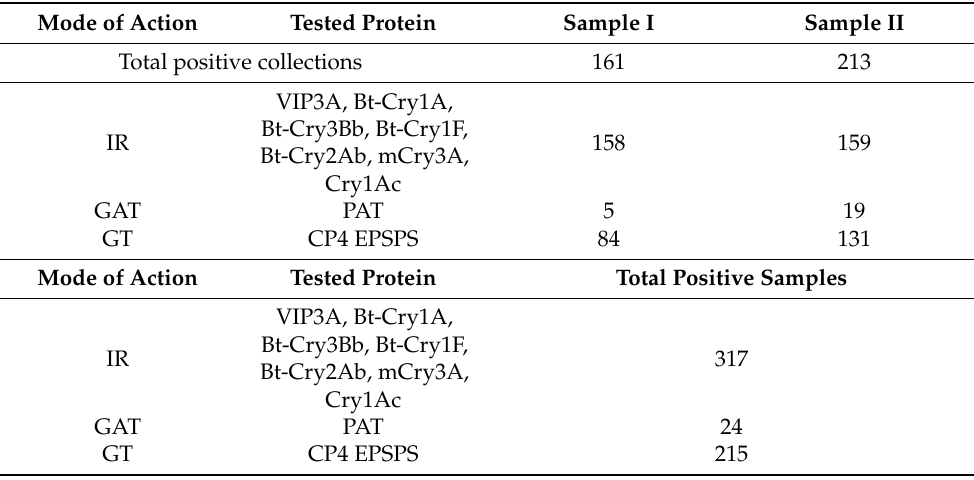
Table 1. Detection of protein by mode of action (insect resistance (IR) and tolerance to glyphosate (GT) and glufosinate-ammonium (GAT) herbicides) in Sample I (2018–2019) and Sample II